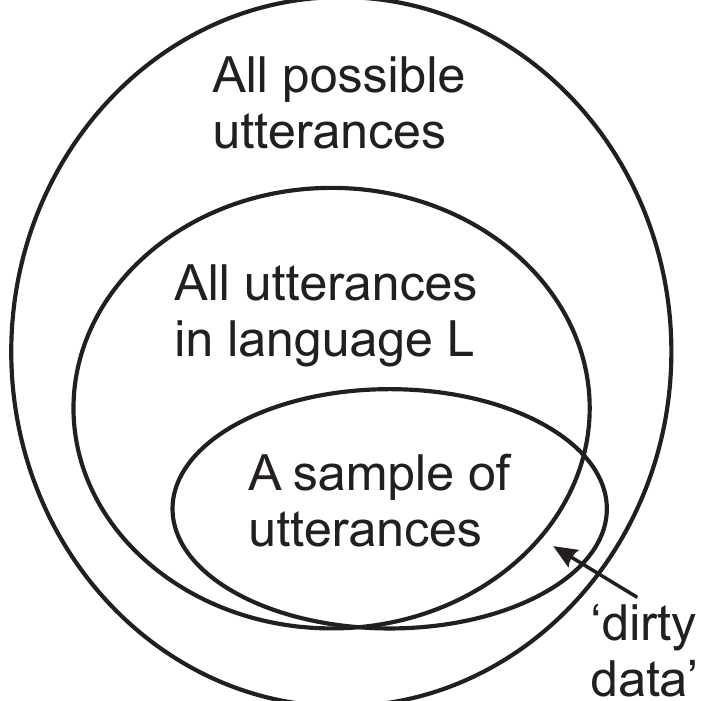
Figure 2. Categories of utterances involved in the learning of a first language, L . In ascending order of size, they are: the finite sample of utterances from which a child learns; the (infinite) set of utterances in L ; and the larger (infinite) set of all possible utterances. Adapted from Figure 7.1 in [14], with